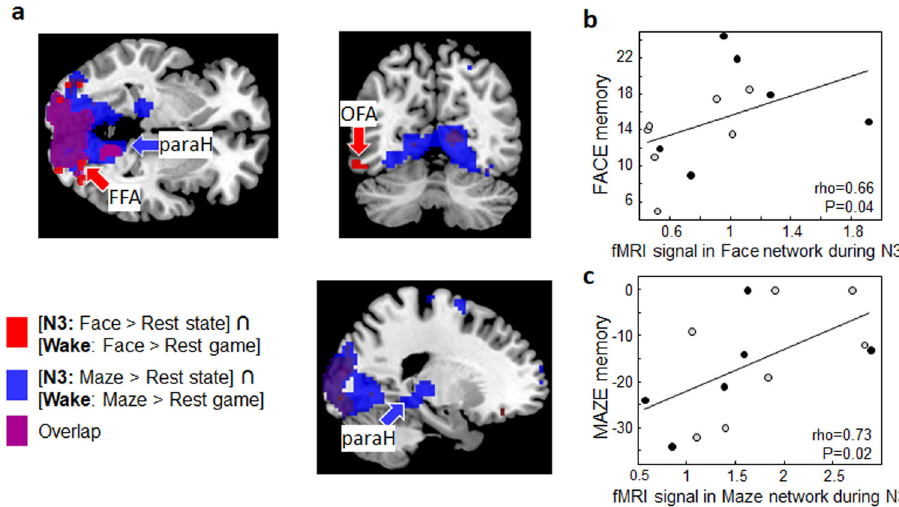
Fig. 4 Game-speci fi c reactivation during N3 and subsequent memory ( N = 13). a In red, brain regions more activated for Face than Rest brain state during N3 sleep, and also recruited during the execution of the task at wake (blocks of Face vs. Rest; conjunction analysis). This network included, among other regions, early visual cortices and the fusiform and occipital face regions. In blue, brain regions more activated for Maze than Rest brain state during N3 sleep, and also recruited during the maze game (blocks of Maze vs. Rest; conjunction analysis). This network included, among others, early visual cortices, the hippocampus and parahippocampal cortex. In purple, overlap between those face and maze reactivation networks during sleep. b Correlation between activity in the face network (red regions in a ) during N3 and memory performance for the face game. c Correlation between activity of the maze network (blue regions in a) during N3 and memory for the maze game. Gray dots for participants who won the face game; black dots for participants who won the maze game. FFA fusiform face area; paraH: parahippocampus, OFA occipital face area. For memory performance measurements, see “ Methods ” . Source data are provided as a Source Data fi